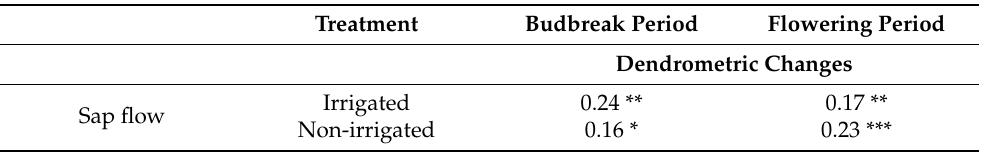
Table 3. Pearson correlation coefficient between sap flow and dendrometric changes in the irrigated and non-irrigated